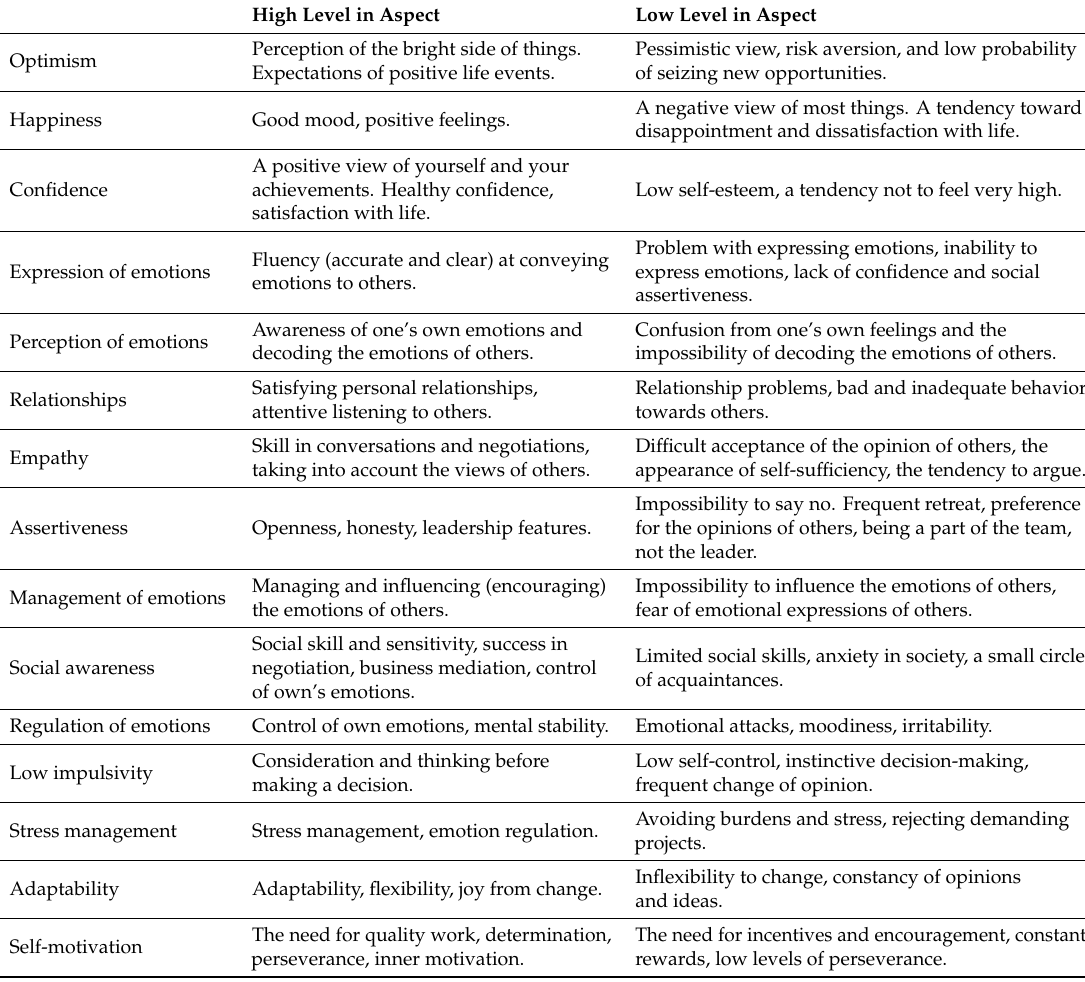
Table 1. Characteristics of high and low levels of trait emotional intelligence. High Level in Aspect Low Level in